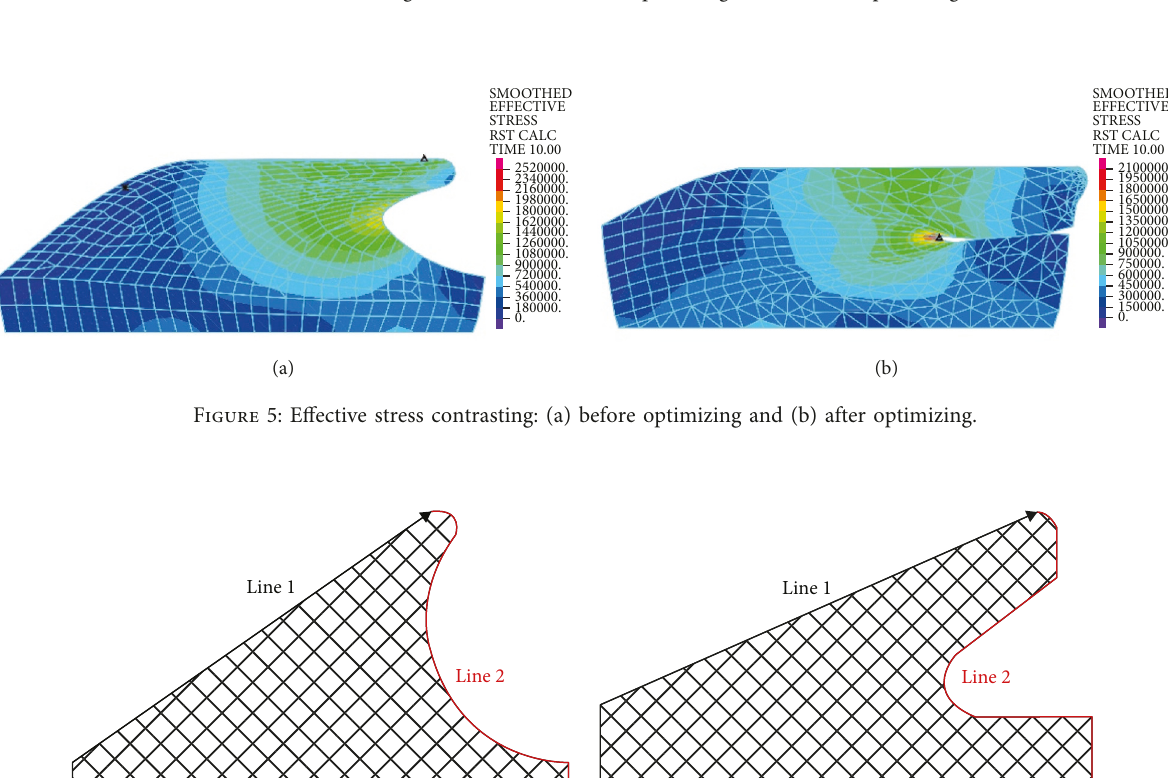
Figure 4: Rubber ring FEM mesh: (a) before optimizing and (b) after optimizing.